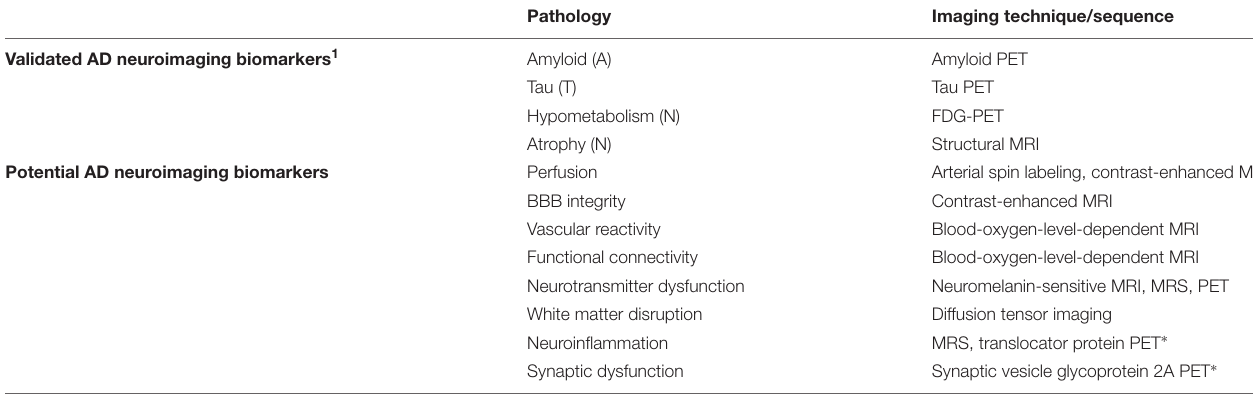
TABLE 2 | Validated and potential neuroimaging-based biomarkers for AD-relevant